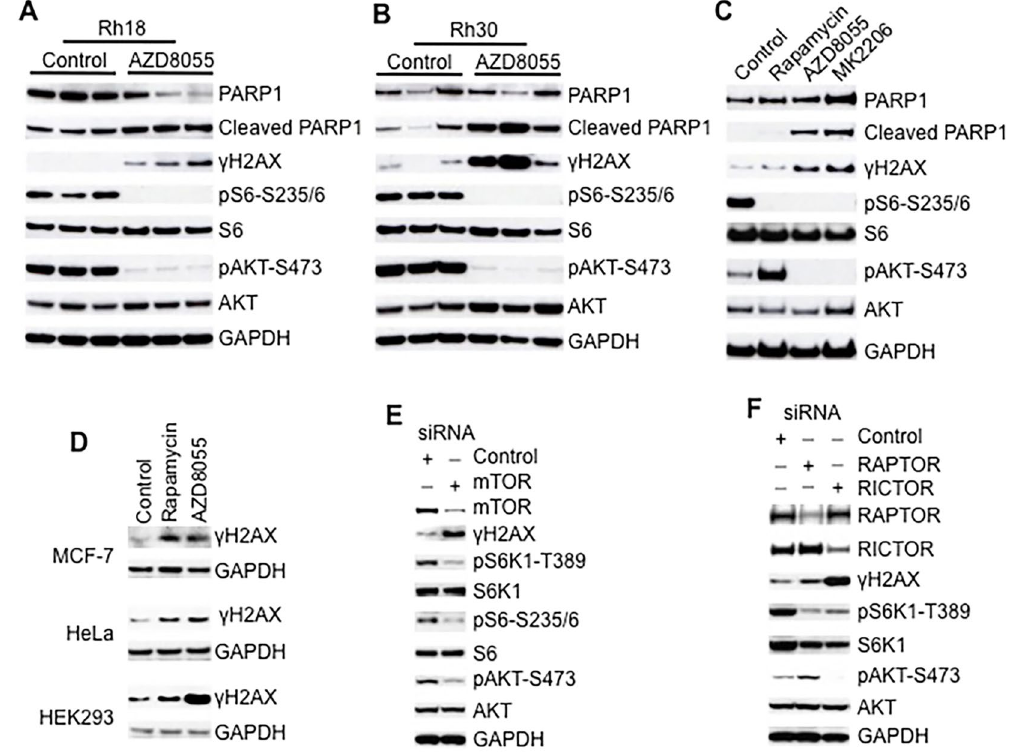
Figure 1. Inhibition of mTOR Signaling Results in DNA Damage. ( A ) Rh18 pediatric rhabdomyosarcoma tumor xenografts were propagated subcutaneously in SCID mice and were treated with mTOR kinase inhibitor AZD8055 at 20 mg/kg/day. Tumors were harvested 24 hr post treatment on day 4 and were pulverized under liquid N 2. Total proteins were extracted for immunoblotting. Three tumors were randomly picked for each group. ( B ) Rh30 pediatric rhabdomyosarcoma tumor xenografts were manipulated and immunoblotting was done as in Fig. 1A. ( C ) Rh30 cells were treated with rapamycin (100 ng/mL), AZD8055 (1 μ M) or MK2206 (10 μ M) for 16 hr. Total proteins were extracted for immunoblotting as in Fig. 1A. ( D ), MCF-7, HeLa and HEK293 cells were treated with rapamycin (100 ng/mL) or AZD8055 (1 μ M) for 16 hr. Total proteins were extracted for immunoblotting of γ H2AX and GAPDH. ( E ) Rh30 cells were transfected with control or mTOR siRNA. 48 hr later, total proteins were extracted for immunoblotting. ( F ) Rh30 cells were transfected with control, RAPTOR or RICTOR siRNA. 48 hr later, total proteins were extracted for immunoblotting. GAPDH served as loading controls. Immunoblots were converted to white and black with auto tone by Photoshop